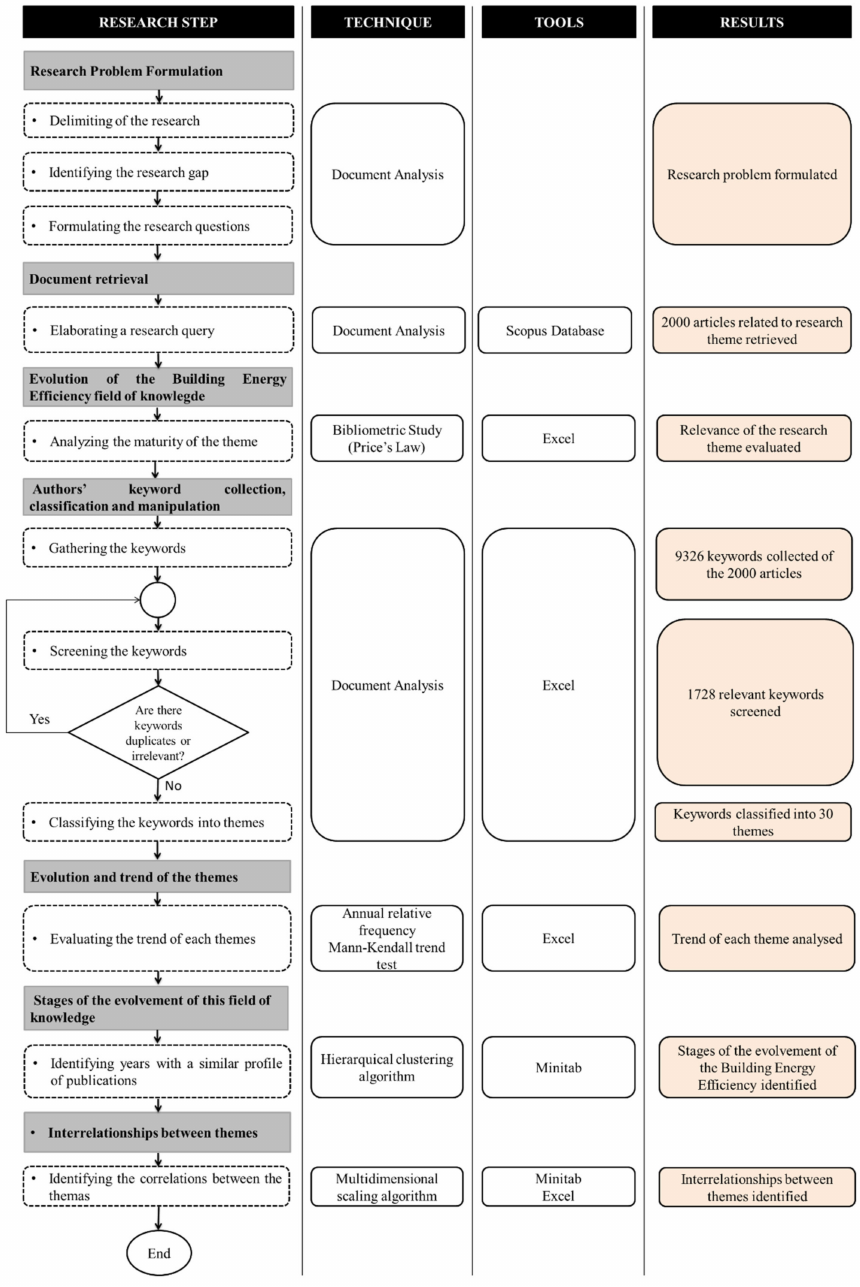
Figure 1. Procedural flow diagram (source: